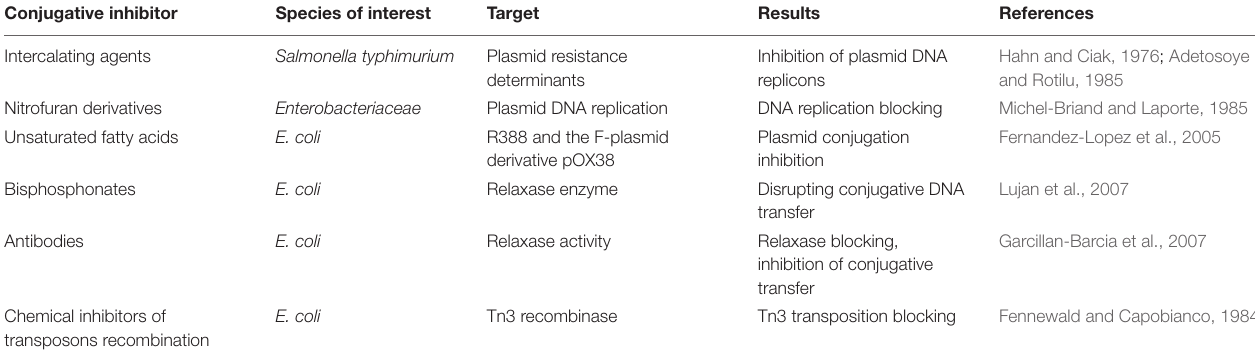
TABLE 2 | Conjugation inhibitors and their targets for the elimination of antibiotic